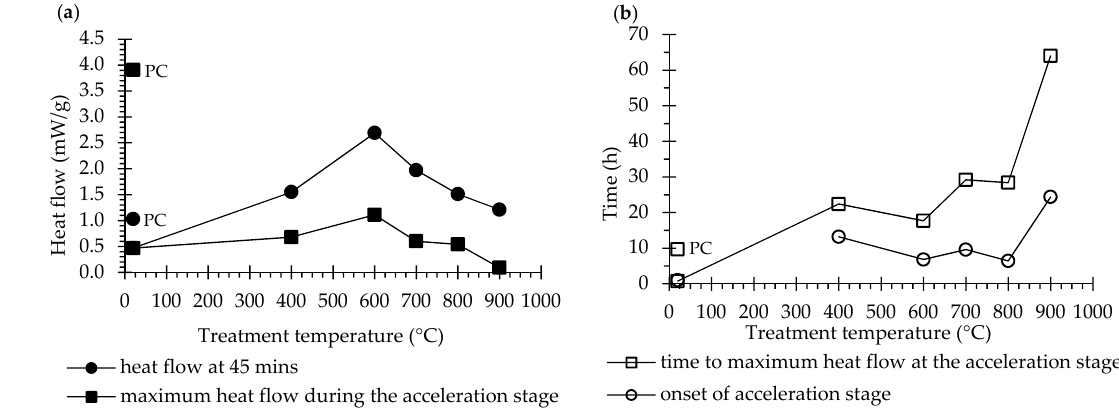
Figure 11. Features of the isothermal calorimetry curves, obtained throughout the hydration process of PC, NT and RC pastes. ( a ) Heat flow: at 45 min (the beginning of the calorimetric register) and maximum during the acceleration stage; ( b ) elapsed hydration time until onset of the acceleration stage and until maximum heat flow at this stage.